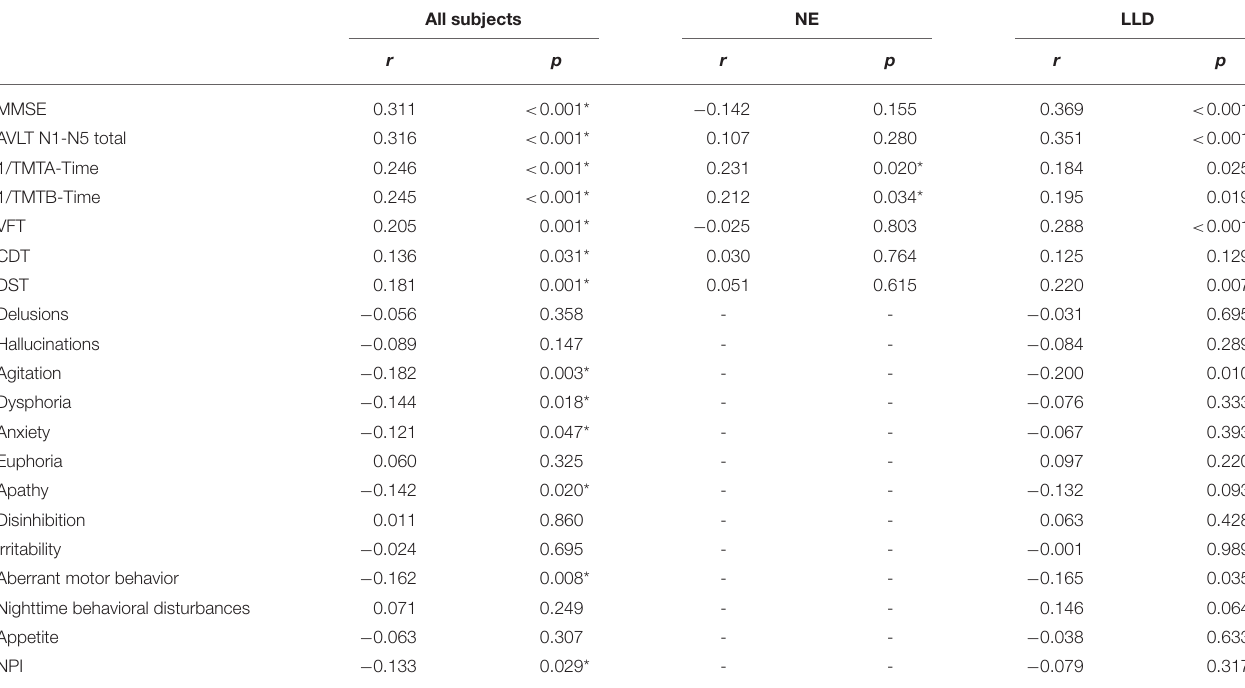
TABLE 2 | Correlations between OI and cognition, OI and NPI.